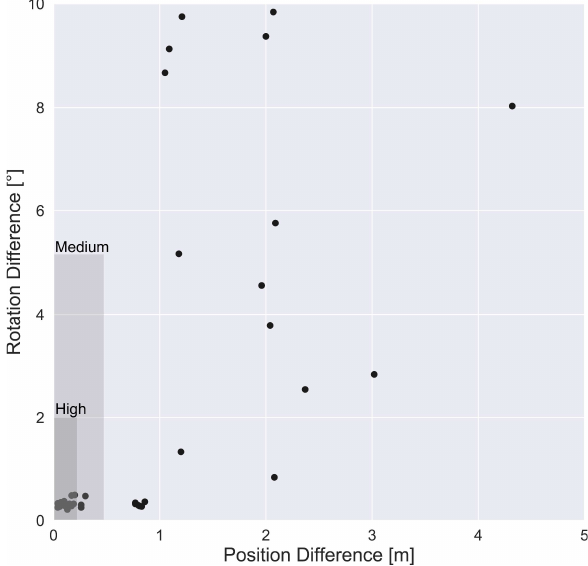
Figure 4. Scatterplot of the positional and rotation differences between processed image poses and ground truth poses